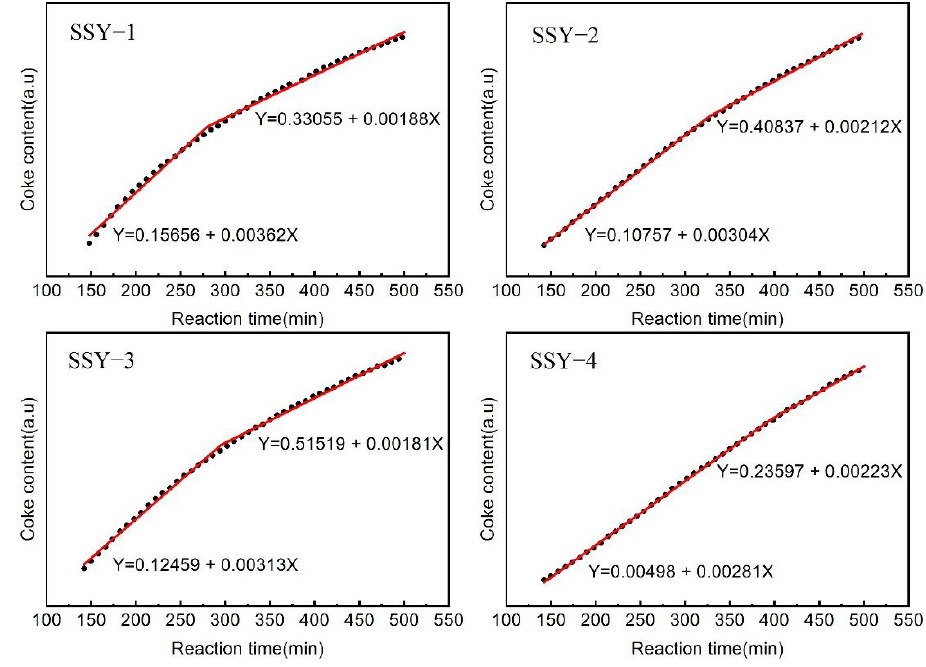
Figure 8. Coke formation rate of ammonium hexafluorosilicate modified zeolites.